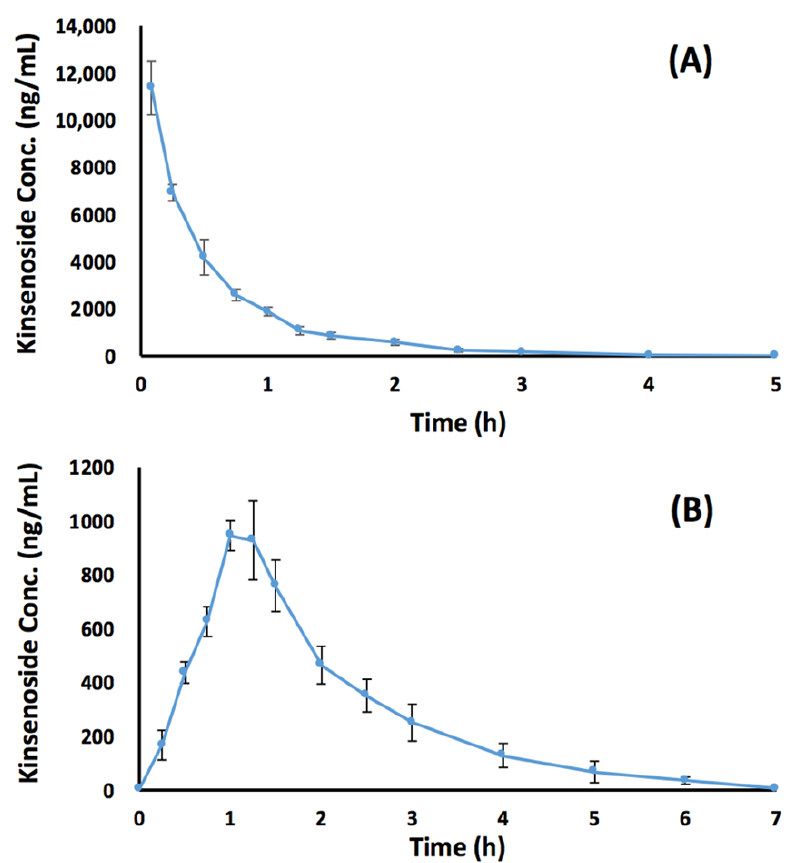
Figure 5. Plasma concentration versus time profiles in beagle dogs following ( A ) intravenous administration and ( B ) oral administration of 3 mg/kg kinsenoside. Data represent mean ± SD obtained from six beagle dogs. Table 4. Major pharmacokinetic parameters in beagle dogs following intravenous or oral administration of kinsenoside at a dose of 3 mg/kg.